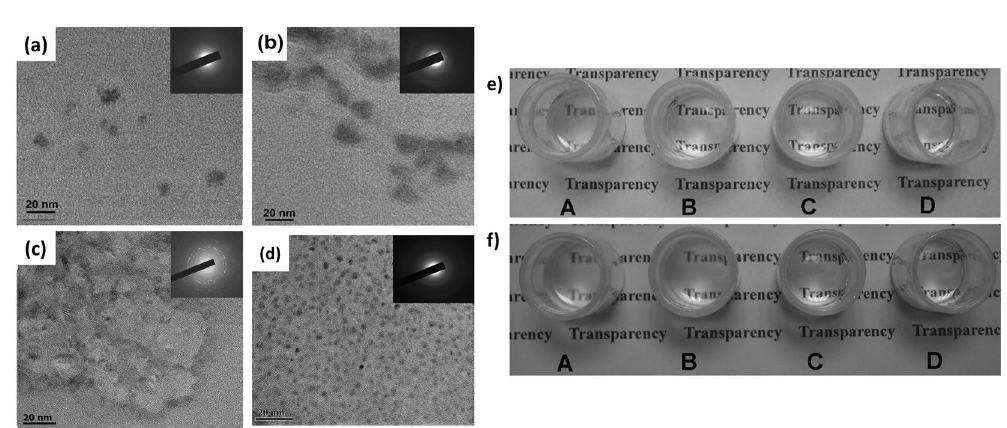
Figure 2. TEM images of ( a ) TiO 2 -1, ( b ) TiO 2 -2, ( c ) TiO 2 -3 and ( d ) S-TiO 2 ; solubility of ( e ) S-TiO 2 and ( f ) silicone resin in (A) acetone, (B) petroleum ether, (C) cyclohexane and (D) acetic